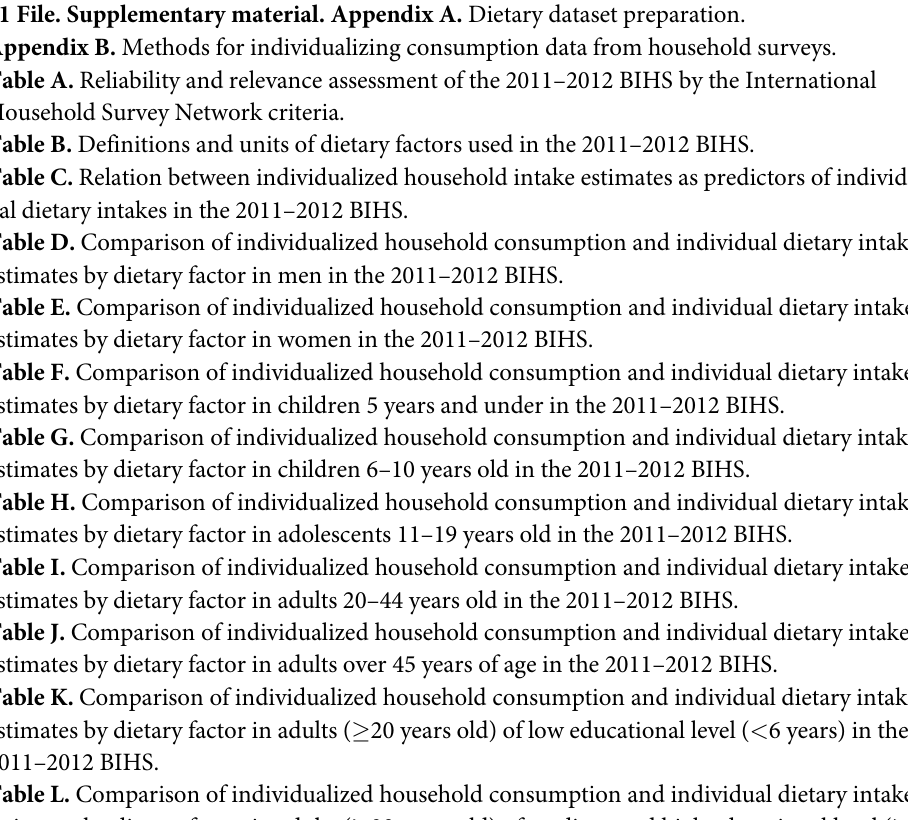
Table L. Comparison of individualized household consumption and individual dietary intake